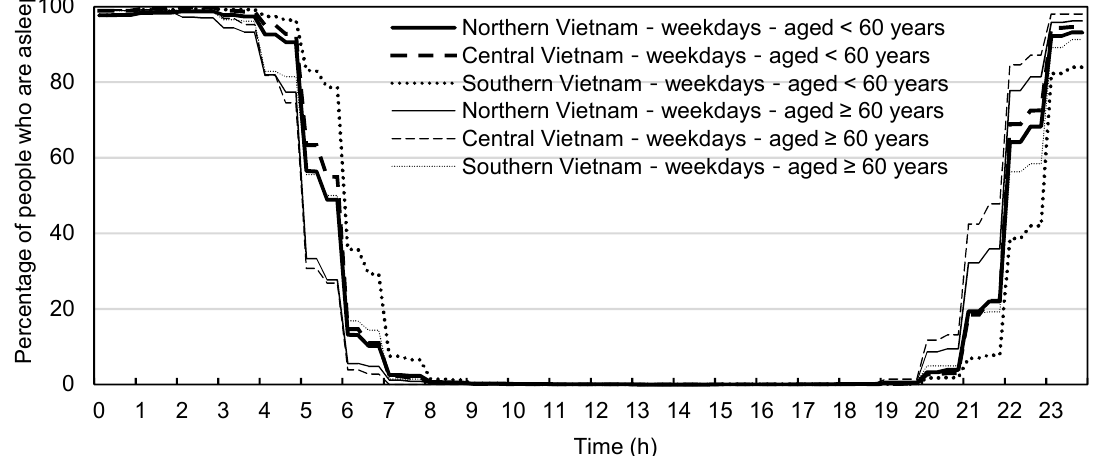
Figure 5. Sex differences in Vietnamese people’s sleeping temporal pattern by region (northern, central, and southern Vietnam) on weekdays. On weekdays, the average wake-up time of respondents aged < 60 years was 6:00–6:15 in all three regions, whereas the average wake-up time of respondents aged ≥ 60 years in northern and